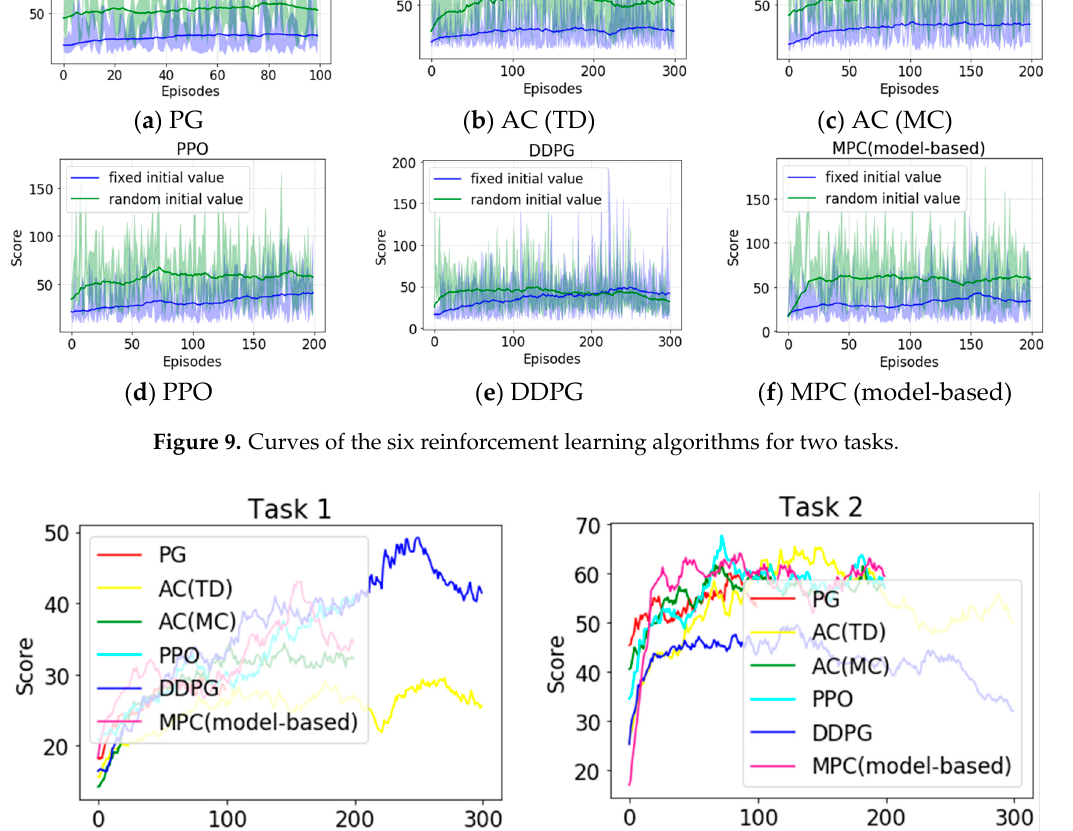
( b ) Task 2 Figure 11. Training times of algorithms. 4.2. Agent Training for the Balance Control of a Biped Robot In this work, we trained the agent to control the upper-body pitching motion of the biped robot for adjusting the ZMP. We used the two algorithms achieving the best perfor- mance for tasks 1 and 2 in Section 4.1, namely, the DDPG and model-based MPC algo- rithms, to train the agent in this experiment. Each episode finished when the robot fell or